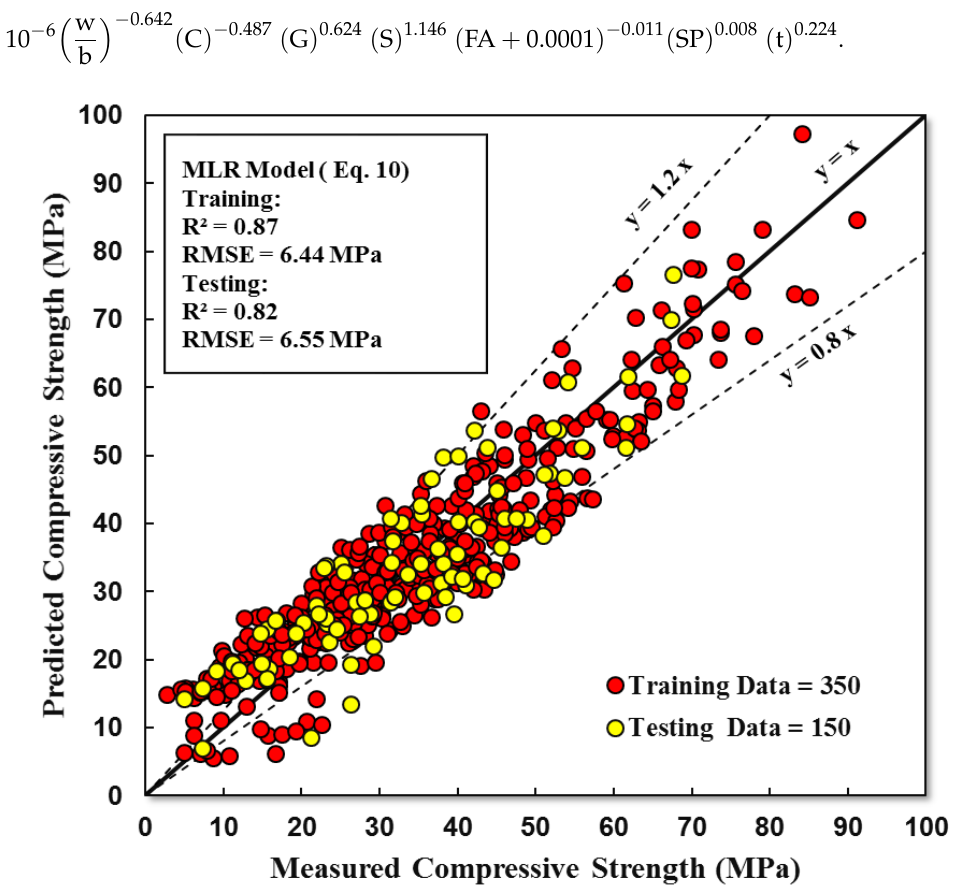
Figure 10. Comparison between measured and predicted compressive strength for MLR model.